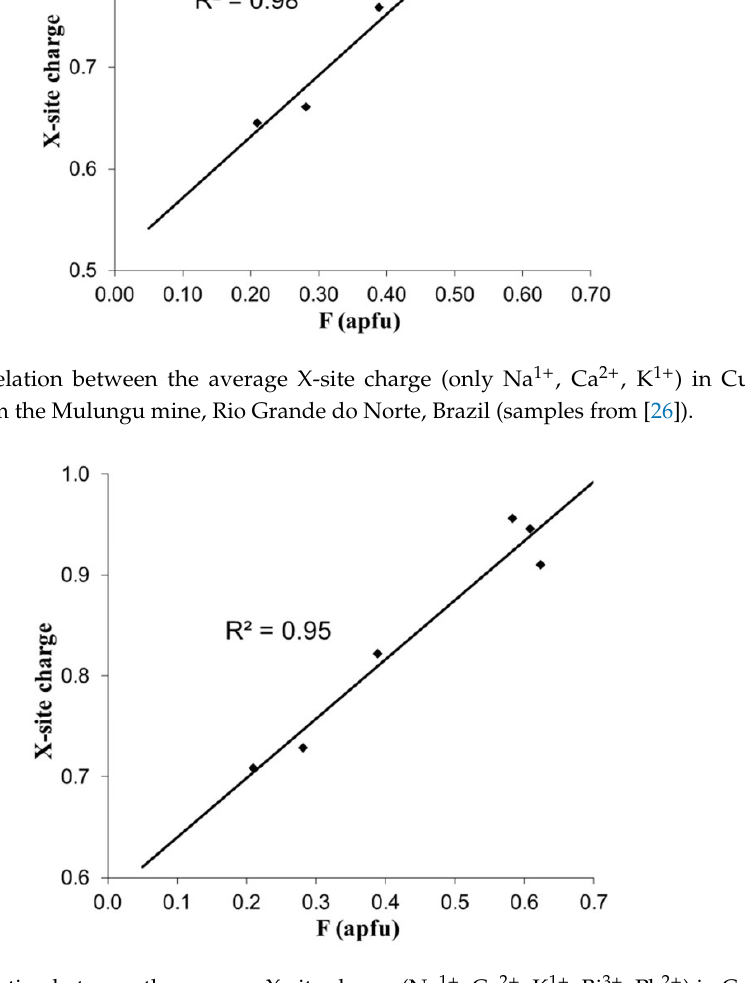
Figure 4. Correlation between the average X-site charge (Na 1 + , Ca 2 + , K 1 + , Bi 3 + , Pb 2 + ) in Cu-bearing tourmalines from the Mulungu mine, Rio Grande do Norte, Brazil (samples from